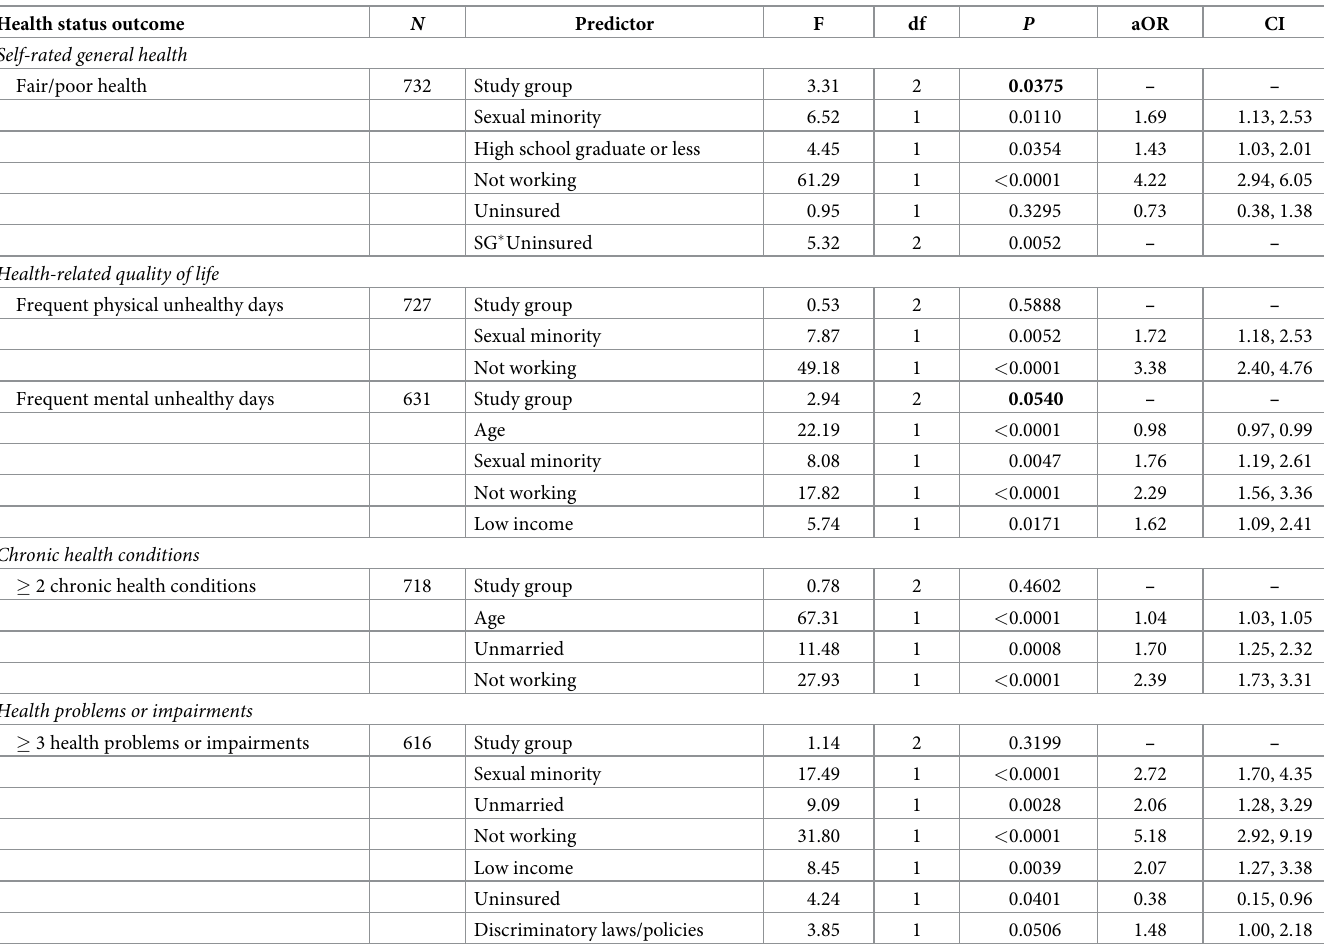
Table 4. Final multivariable model results: Health status